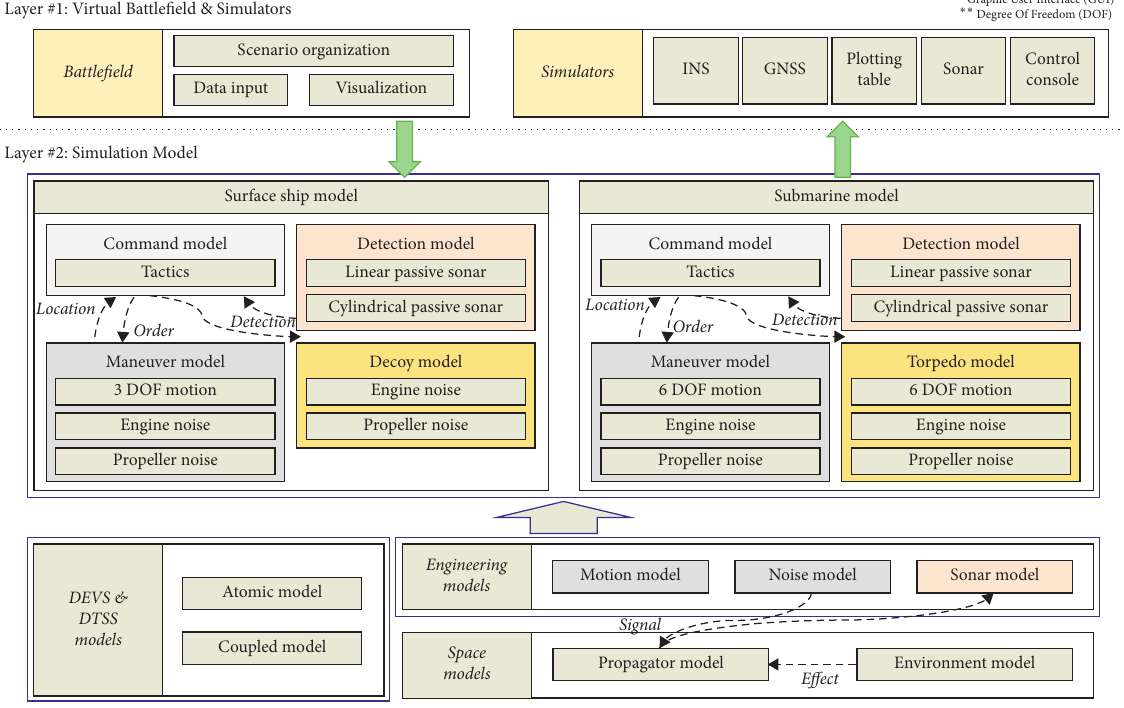
Figure 3: Simulation architecture of combat management simulator [41].